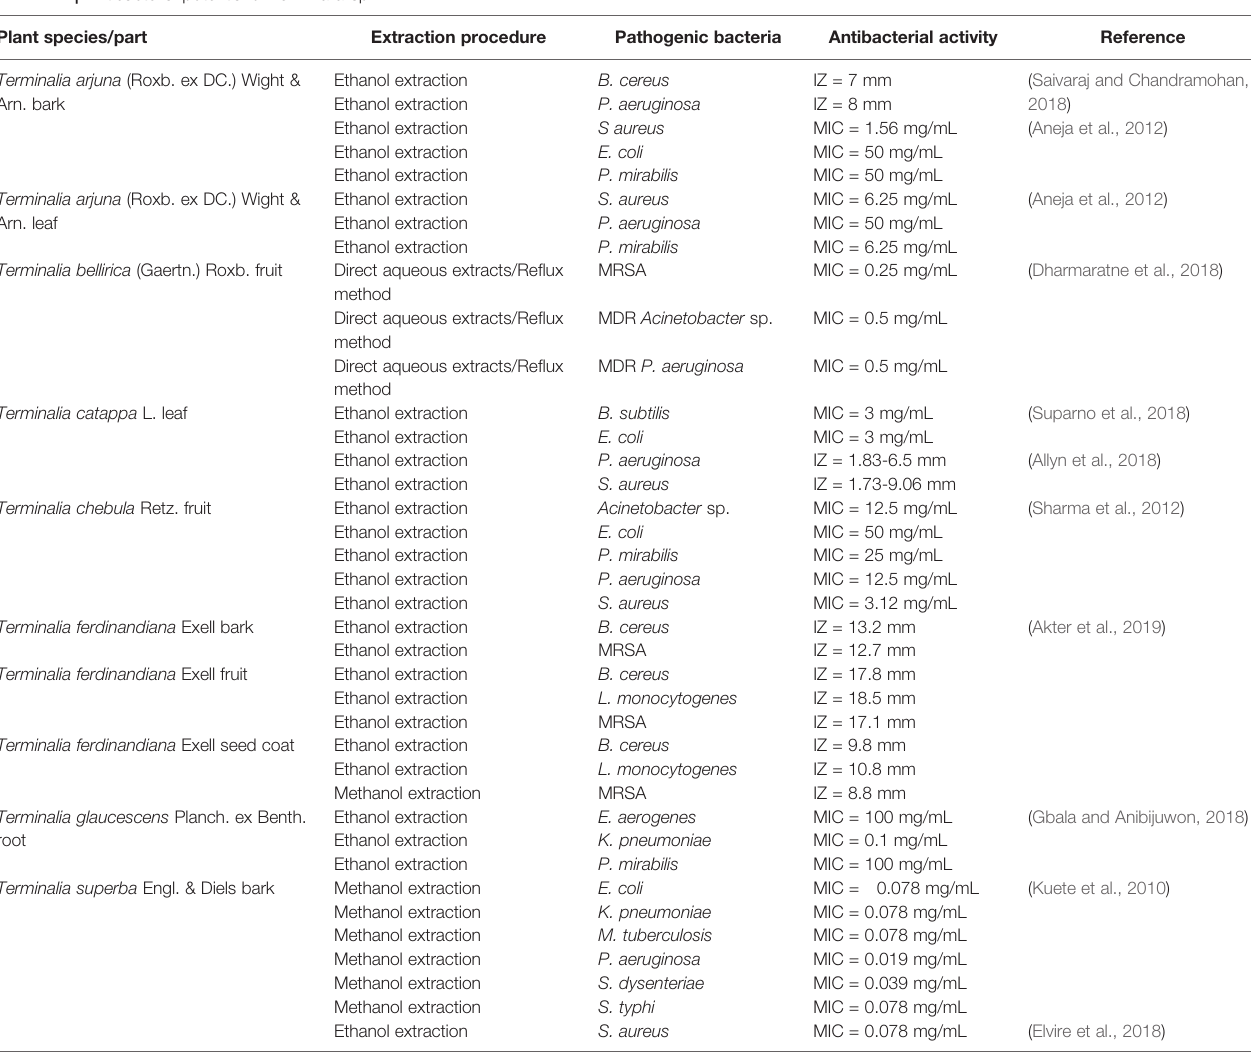
TABLE 7 | Antibacterial potential of Terminalia sp. Plant